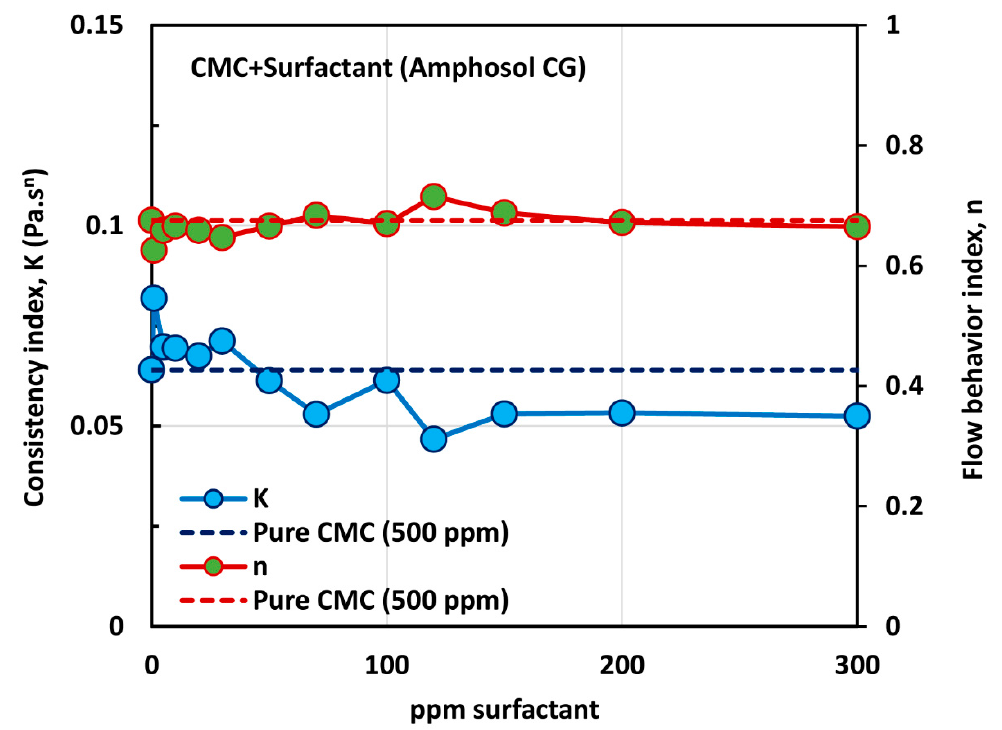
Figure 18. Variations of consistency index, K , and flow behavior index, n , for mixtures of anionic polymer, CMC, and zwitterionic surfactant, Amphosol CG, with the increase in surfactant concentration, at a fixed polymer concentration of 500 ppm.